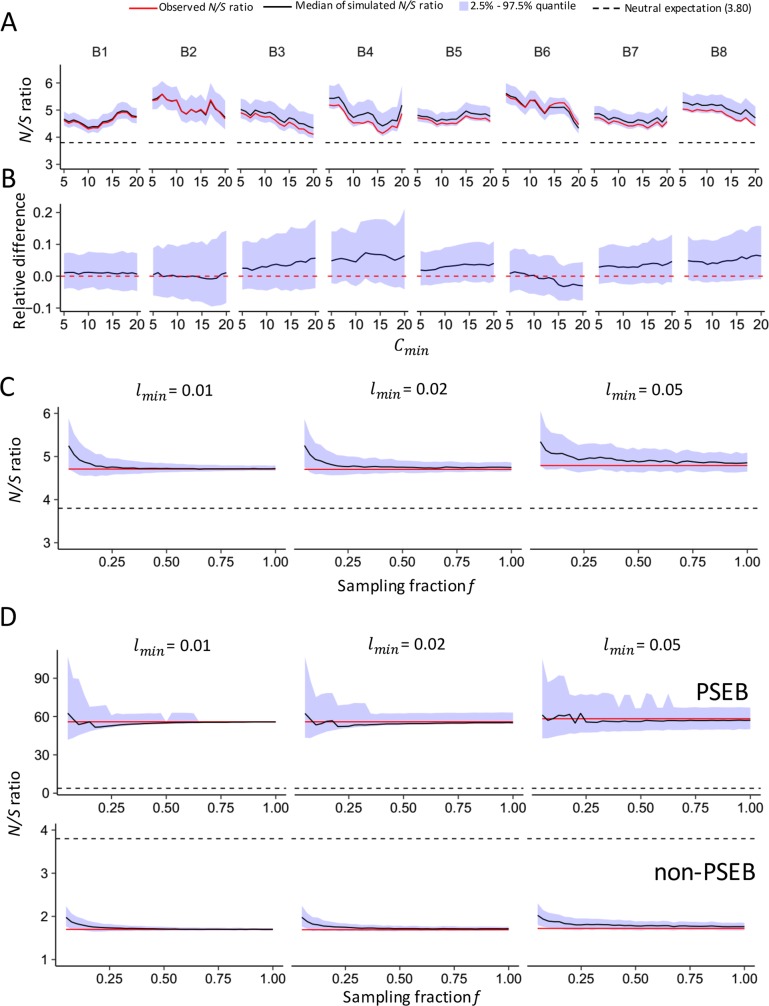
Evaluating the effect of detection bias on N/S ratio estimation.(A) The simulated and observed N/S ratios with increasing cutoffs of sequencing coverage (Cmin). The x-axis is the cutoff of coverage (Cmin) and the y-axis is the simulated (median in black, and the range from 2.5% to 97.5% quantile is in blue) and observed (red) N/S ratio. The N/S ratio under neutral evolution (3.80) is indicated with dashed lines. lmin is 0.02 here. (B) The relative difference of the simulated vs. the observed N/S ratio with increasing Cmin. Each plot is corresponding to the upper one in (A). (C) The simulated (median in black and the range from 2.5% to 97.5% quantile in blue) and observed (red) N/S ratios (the y-axis) when pooling all the brain libraries together and randomly sampling a fraction (f, from 0.05 to 1, the x-axis) of reads. Results with the cutoff of editing level, lmin = 0.01, 0.02 and 0.05 are presented. The N/S ratio under neutral expectation (3.80) is indicated with dashed lines. (D) The simulations of the editing sites in PSEB (upper panel) and non-PSEB genes (lower panel) as in (C).